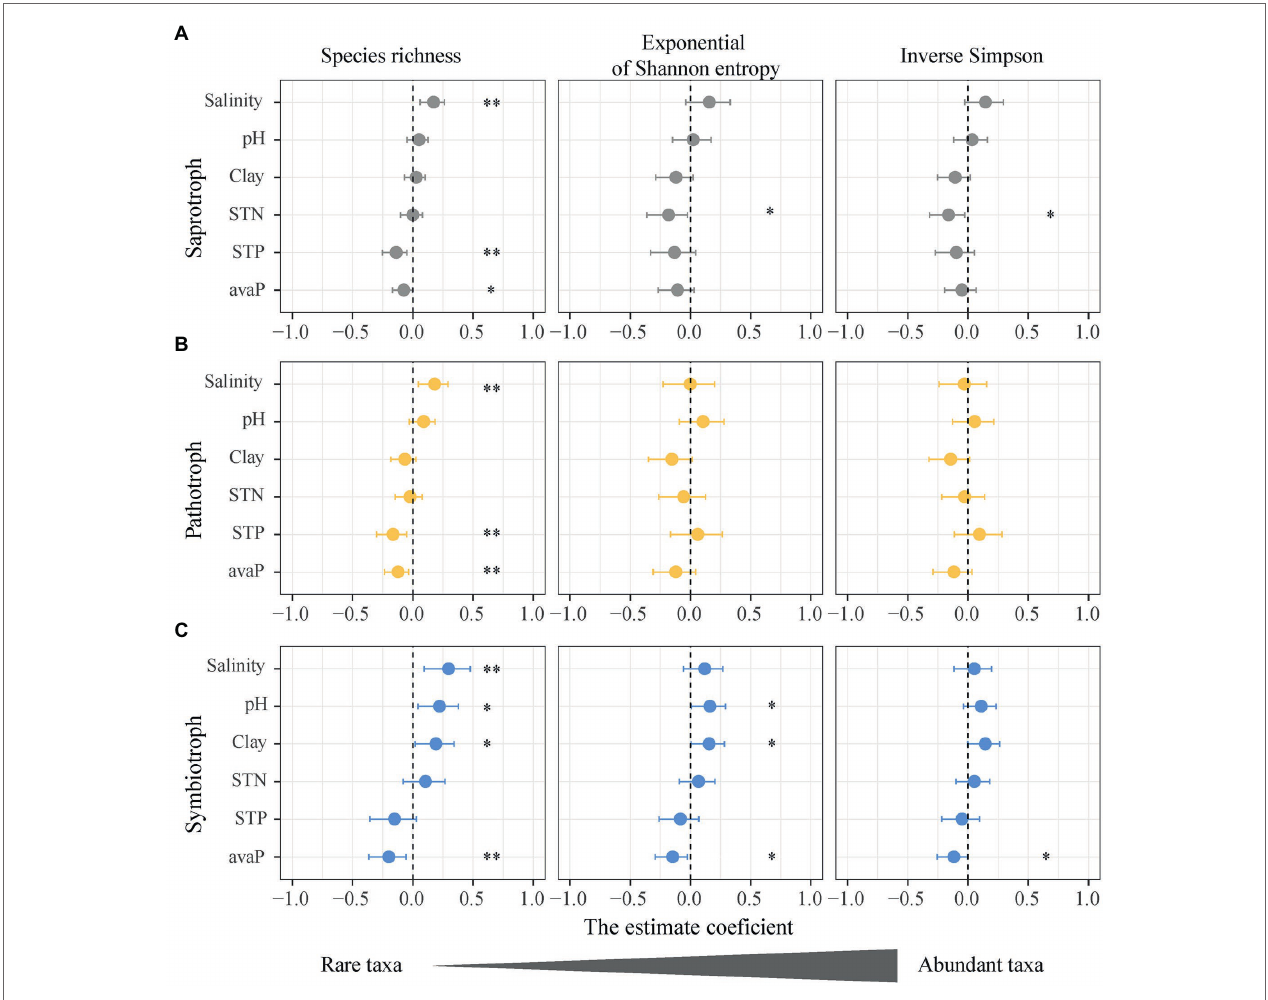
FIGURE 4 | Impacts of soil salinity and properties on the alpha diversity of functional guilds of soil fungi. (A) Saprotrophic fungi; (B) pathotrophic fungi; (C) symbiotrophic fungi. Points denote regression coefficients and error bars denote 95% confidence intervals. * p < 0.05; ** p < 0.01. Abbreviations: Salinity, soil salinity; STN, soil total nitrogen; Clay, soil clay content; STP, soil total phosphorus; avaP, soil available